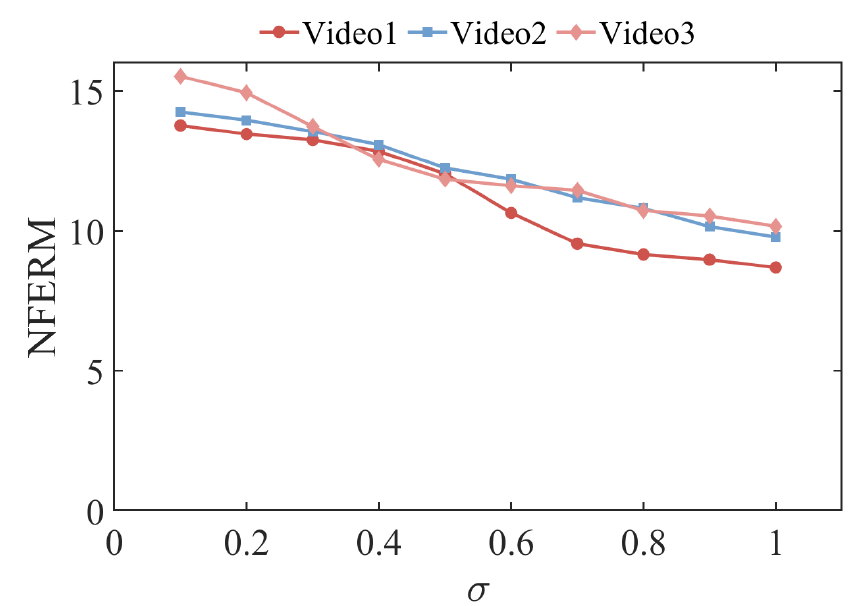
Figure 11. NFERM results for Video 1 (containing the Align 700L V2 obstacle object), Video 2 (containing the DJI F450 obstacle object), and Video 3 (containing the DJI Mavic 2 Pro obstacle object) using the proposed algorithm at different σ values. The lower the NFERM, the better the